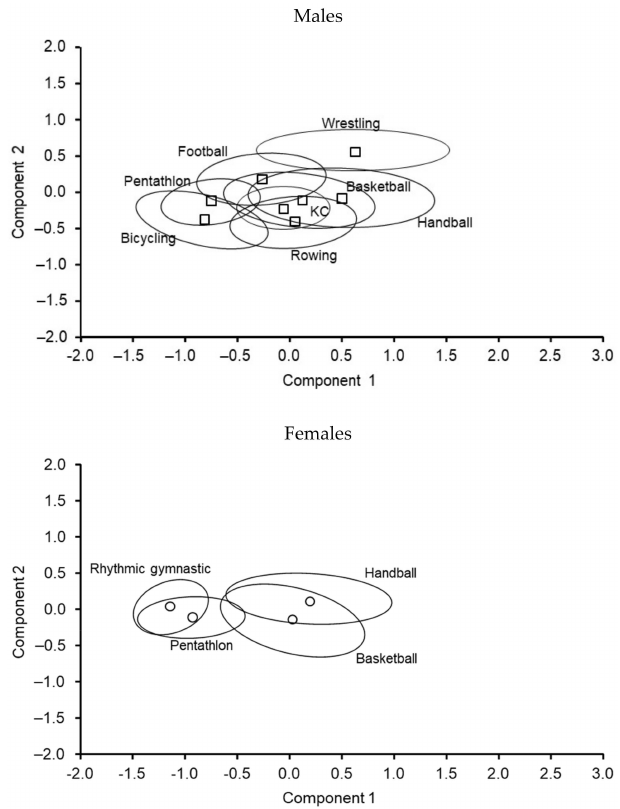
Figure 3. Distribution of PC scores by component (PC 1 on the x-axis and PC 2 on the y-axis) among youth athletes by sport ( (cid:3) and : sport type mean and 95% confidence ellipse around the mean). (cid:35)